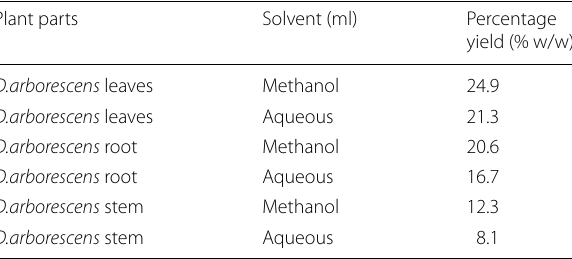
Table 1 Yield of extracts (%) from the leaves, roots and stem of Dictyandra arborescens